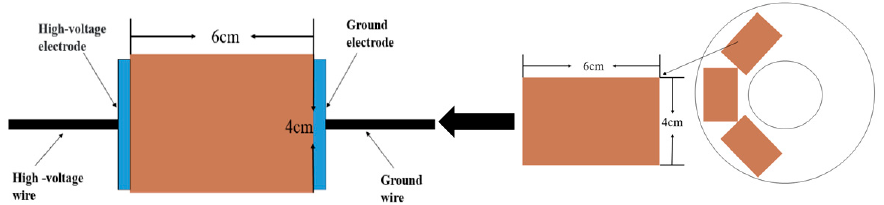
Figure 5. Schematic diagram of samples and the electrodes in the electrical test.